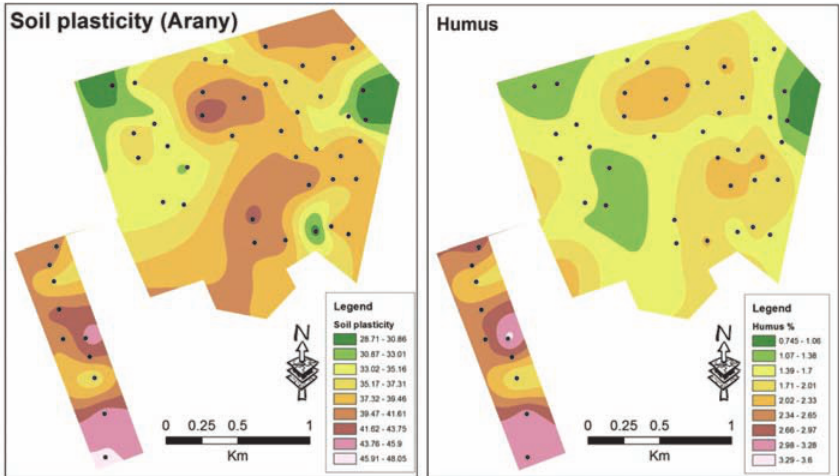
Figure 2. Spatial distribution of soil plasticity and humus